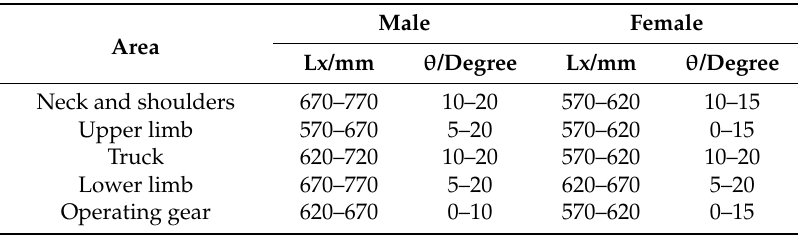
Table 3. Optimal adjustable range [10].